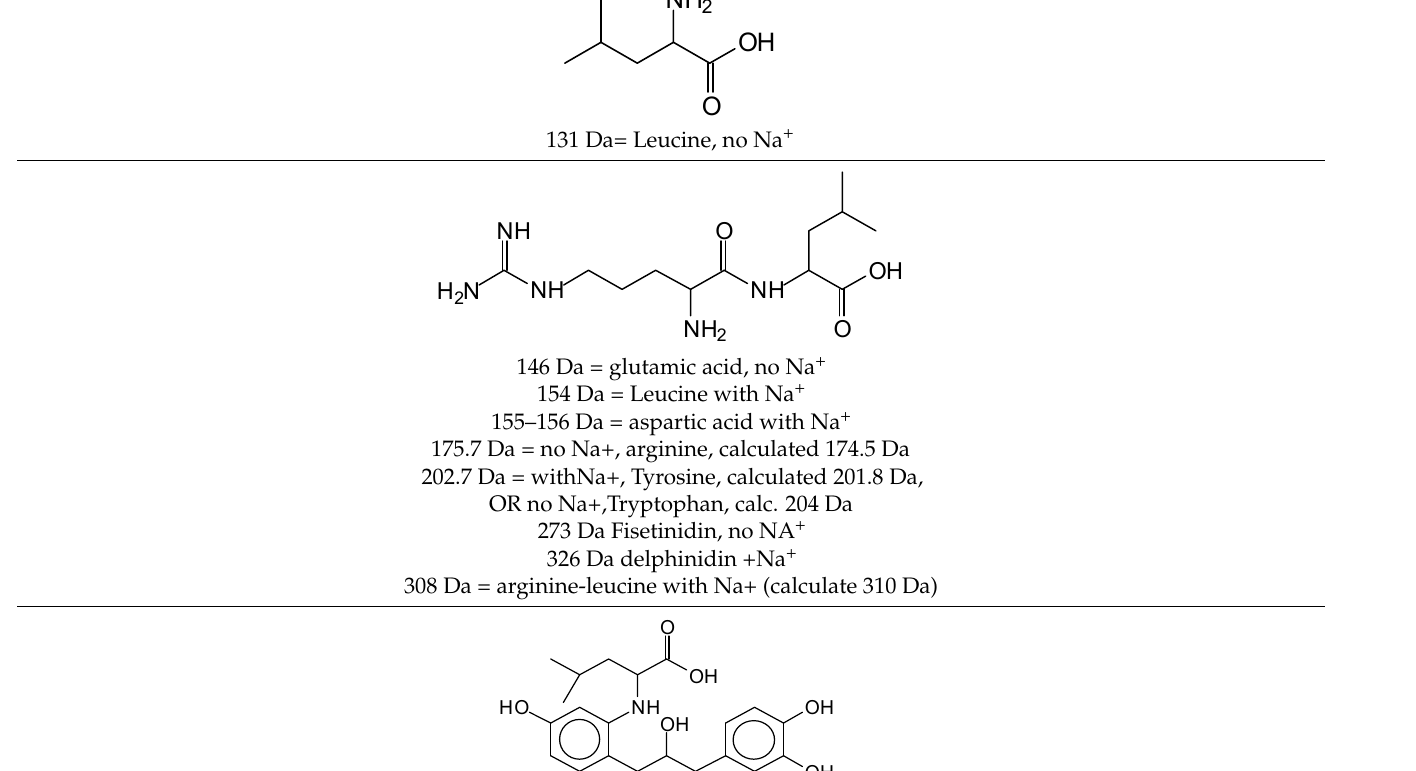
131 Da= Leucine, no Na